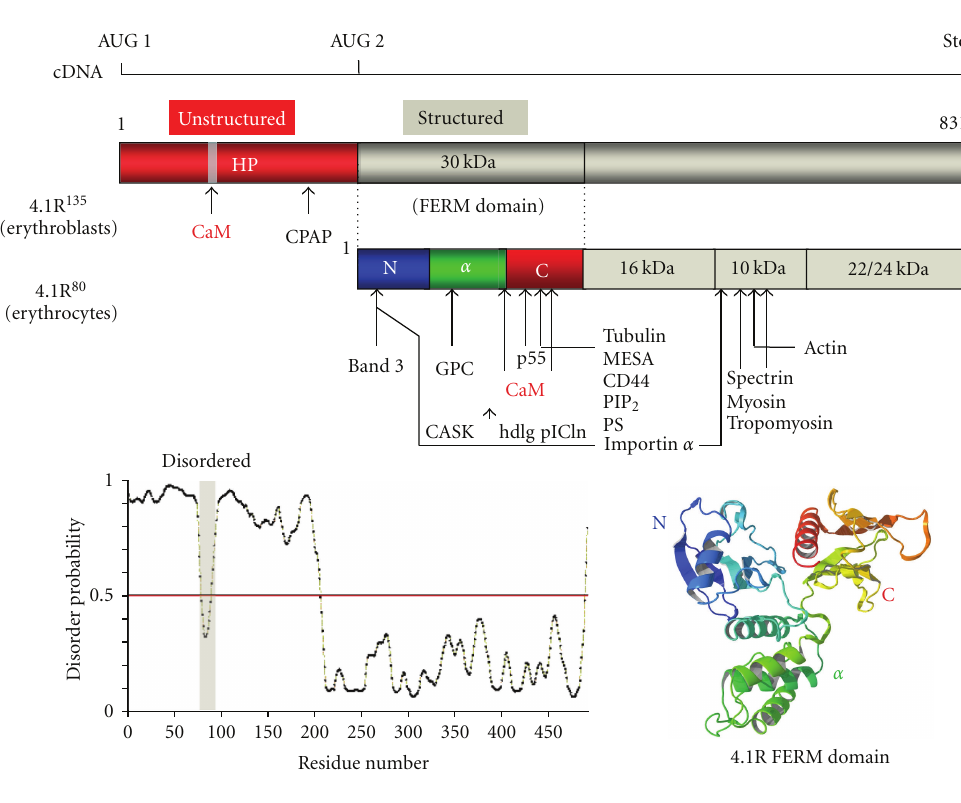
Figure 4: Primary structure of 4.1R isoforms and map of known binding partners for 4.1R. Translation of the prototypical red blood cell 80 kDa 4.1R isoform (4.1R 80 ) is initiated at AUG-2, which is located in exon 4. Translation of the 135kDa 4.1R isoform (4.1R 135 ), an isoform expressed in early erythroblasts and other nucleated cells, is initiated at AUG-1, which is located in exon 2 (cid:3) (ID: P11171). The 30kDa membrane-binding domain is the so-called “FERM” domain. Disorder prediction for each domain has been established through the use of the PrDOS software package. An updated list of the binding partners identified for each domain of 4.1R is displayed. CPAP refers to a “ centrosomal protein 4.1R-associated protein ” reported by Hung et al. [24]. A 3D representation of the 30 kDa FERM domain of 4.1R, visualized with the MolFeat Ver. 4.6 software, is displayed (PDB accession no. 1GG3). The 30 kDa domain consists of three lobes (N-, α -, and C-lobe) and adopts a three-leaf clover shape [25].